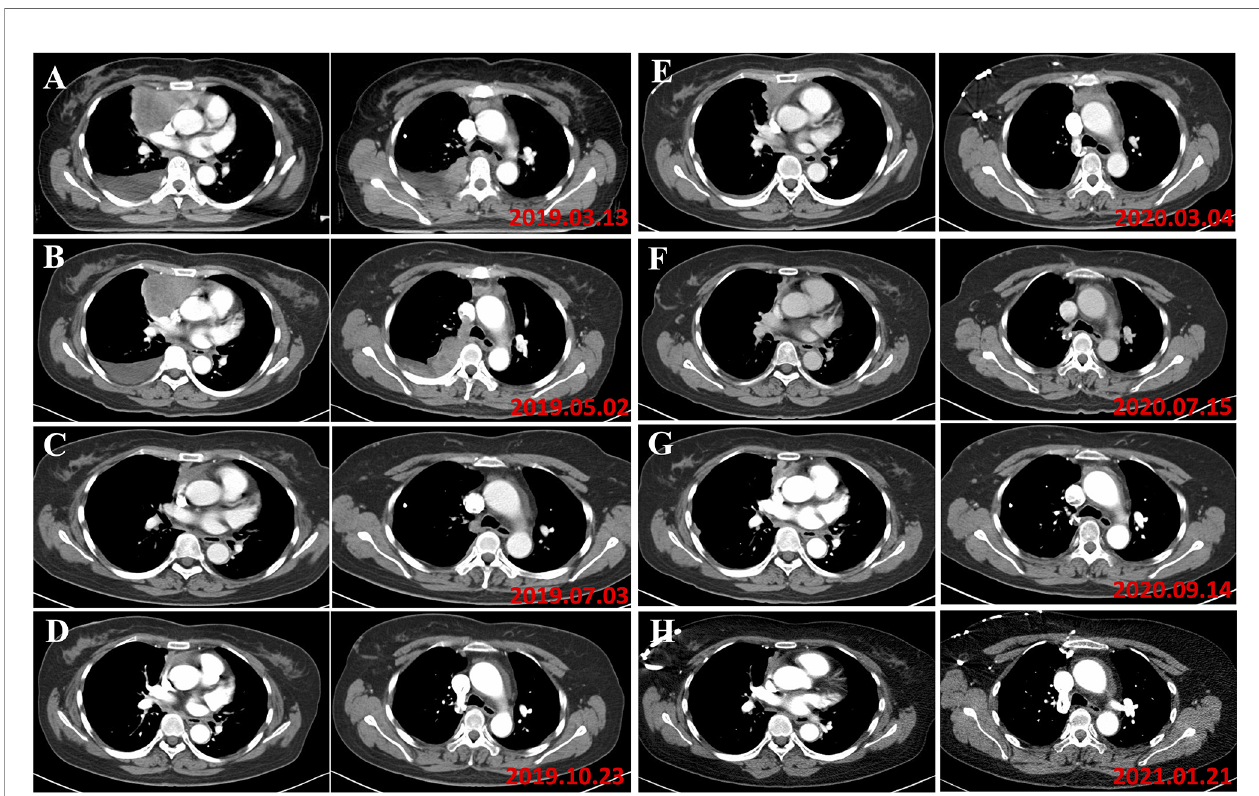
FIGURE 4 | (A) In March 2019, the patient was diagnosed as type B3 thymoma with pleural dissemination, and her clinical stage was Masaoka stage IVA. (B) In May 2019, the evaluation of tumor response to chemotherapy is SD (RECIST). (C) In August 2019, the tumor responded to pembrolizumab. (D) In October 2019, a near complete response was achieved following a dose of pembrolizumab. (E) In March 2020, the disease progressed and 100 mg of pembrolizumab was administered. (F) The patient responded to 100 mg pembrolizumab with partial regression. (G) In September 2020, progression of the disease was found. (H) The patient responded to 100 mg pembrolizumab